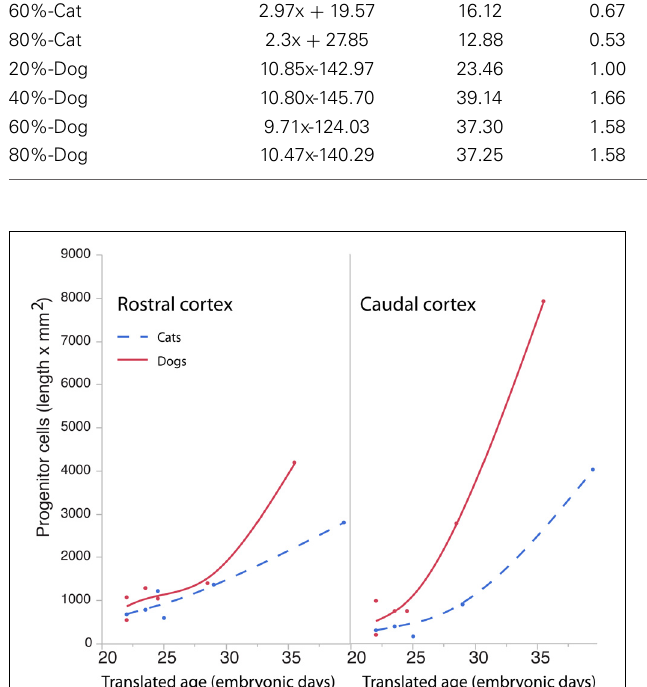
FIGURE 9 | The cortical ventricular length was divided into a rostral and caudal region in cats and dogs. The length of the rostral and caudal cortex becomes larger in dogs than in cats toward the latest ages examined. The rostral cortex becomes roughly twice as long in dogs compared with cats and the caudal cortex becomes three times longer in dogs compared with cats at the latest ages examined. have a lengthened neurogenetic schedule relative to cats, a longer duration of neurogenesis implies an extension in the duration of cell proliferation in the caudal pole relative to the rostral